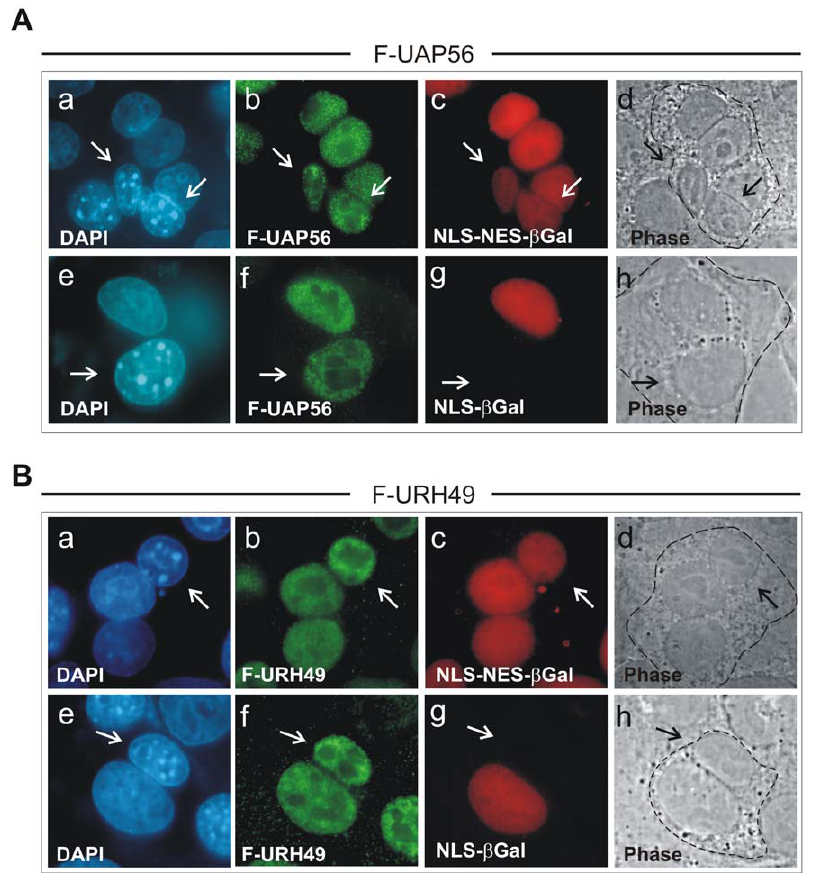
Figure 2. Nucleocytoplasmic shuttling of UAP56 (A) and URH49 (B) in transfected HeLa cells. HeLa cells were cotransfected with expression plasmids for FLAG-UAP56 (panel A) or FLAG-URH49 (panel B) and one of the internal control plasmids as indicated (a–d, + CFNrev- b Gal; e– f, + CFN- b Gal). The transfected cells were subjected to an interspecies heterokaryon assay as described in the Materials and Methods section. In order to detect and discriminate the respective proteins, double immunofluorescence analysis was performed using polyclonal anti-FLAG serum (b and f) and monoclonal anti- b -galactosidase antibody (c and g). DAPI, counterstaining of the nuclei (a and e); Phase, phase contrast image of the heterokaryon (d and h); murine nuclei are indicated by